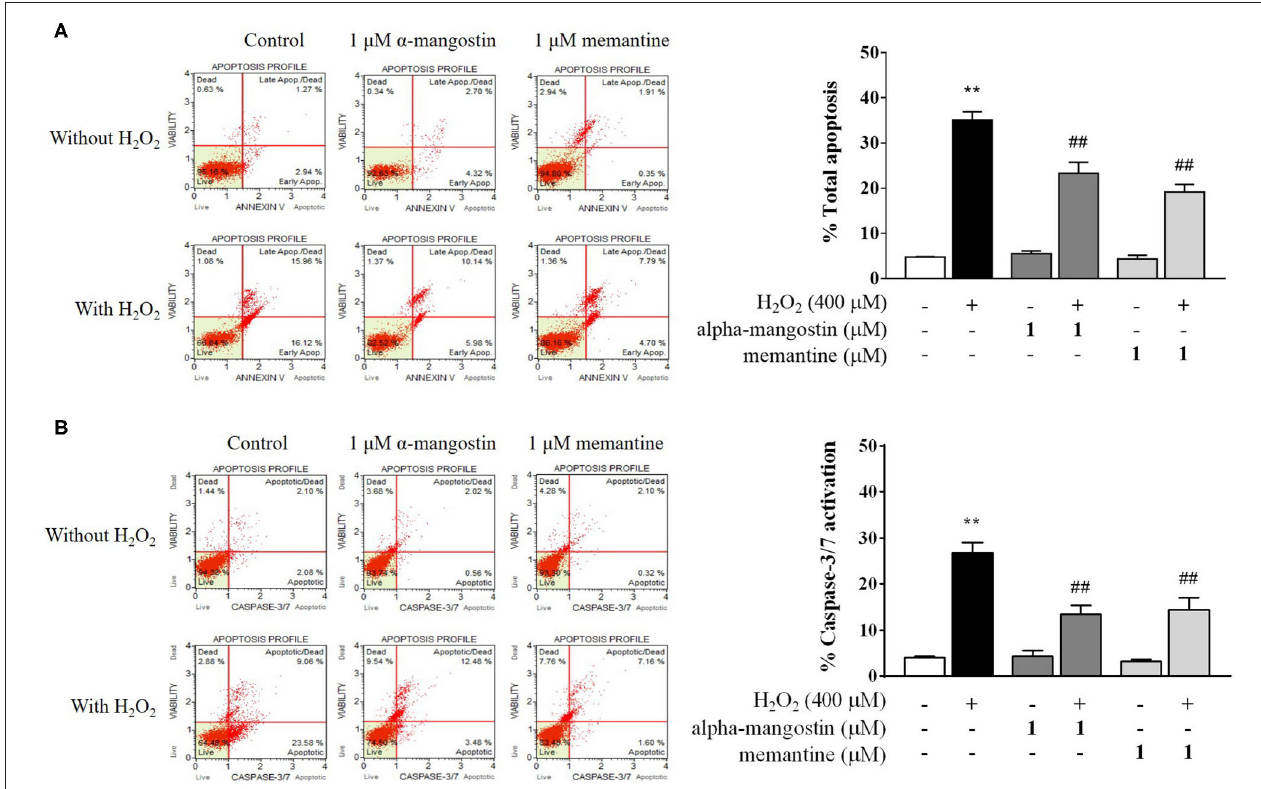
FIGURE 2 | Evaluation of apoptotic profiles of SH-SY5Y cells pretreated with alpha-mangostin and memantine against H 2 O 2 exposure using the Muse Cell Analyzer. Representative scatter plots of live (lower left), early apoptotic (lower right), late apoptotic (upper right), and dead cell (upper left) were measured by assay of (A) Annexin/7-AAD and (B) Caspase-3/7 activation. Early and late apoptotic rates were presented as percentages of total apoptosis. Data are presented as mean ± SEM of four independent experiments. ** P < 0.01 vs. control and ## P < 0.01 vs. H 2 O 2